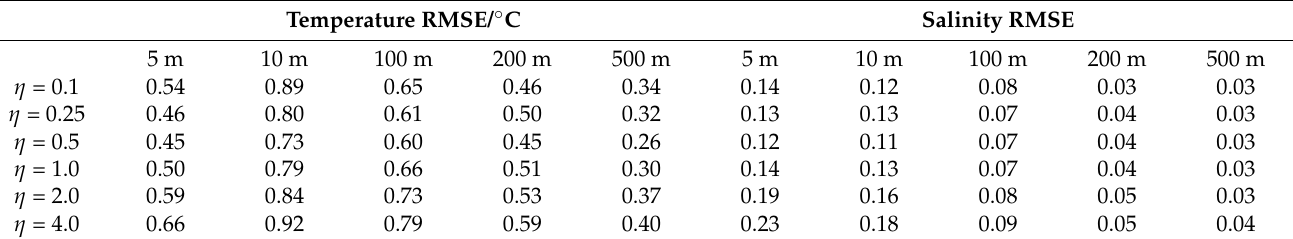
Table 1. RMSEs of temperature and salinity with different value of η . Temperature RMSE/ ◦ C Salinity